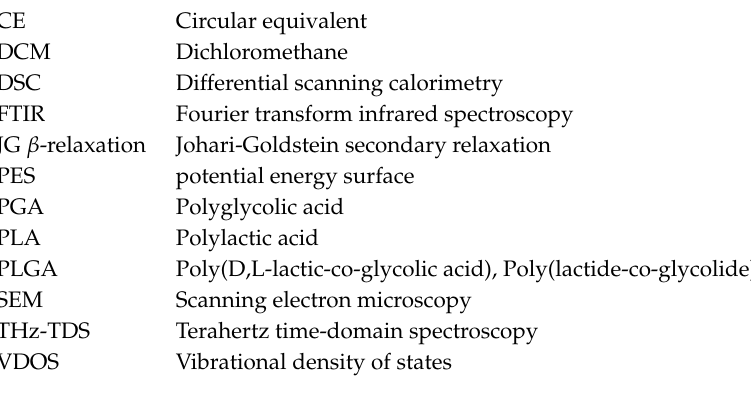
sample over 0.1–2.8 THz in the temperature range of 100–350 K, Figure S14: Terahertz absorption spectra of a low polypeptide loaded PLGA 75:25 microsphere sample over 0.3–2.8 THz in the temperature range of 100–350 K, Figure S15: Refractive index spectra of a low polypeptide loaded PLGA 75:25 microsphere sample over 0.1–2.8 THz in the temperature range of 100–350 K, Figure S16: Terahertz absorption spectra of a low polypeptide loaded PLGA 50:50 microsphere sample over 0.3–2.8 THz in the temperature range of 100–370 K, Figure S17: Refractive index spectra of a low polypeptide loaded PLGA 50:50 microsphere sample over 0.1–2.8 THz in the temperature range of 100–350 K, Figure S18: Terahertz absorption spectra of a low polypeptide loaded PLGA 75:25 microsphere sample over 0.3–370 THz in the temperature range of 100–350 K, Figure S19: Refractive index spectra of a low polypeptide loaded PLGA 75:25 microsphere sample over 0.1–3 THz in the temperature range of 100–370 K, Figure S20: Terahertz absorption spectra of a high polypeptide loaded PLGA 50:50 microsphere sample over 0.3–2.8 THz in the temperature range of 100–370 K, Figure S21: Refractive index spectra of a high polypeptide loaded PLGA 50:50 microsphere sample over 0.1–2.8 THz in the temperature range of 100–370 K, Figure S22: Terahertz absorption spectra of a medium MW PLGA 50:50 over 0.3–2.2 THz in the temperature range of 90–360 K, Figure S23: Refractive index spectra of a medium MW PLGA 50:50 over 0.3–2.2 THz in the temperature range of 90–360 K, Figure S24: Terahertz absorption spectra of a medium MW PLGA 75:25 sample over 0.3–1.9 THz in the temperature range of 90–350 K, Figure S25: Refractive index spectra of a medium MW PLGA 75:25 sample over 0.3–1.9 THz in the temperature range of 90–350 K. All raw data are available for download